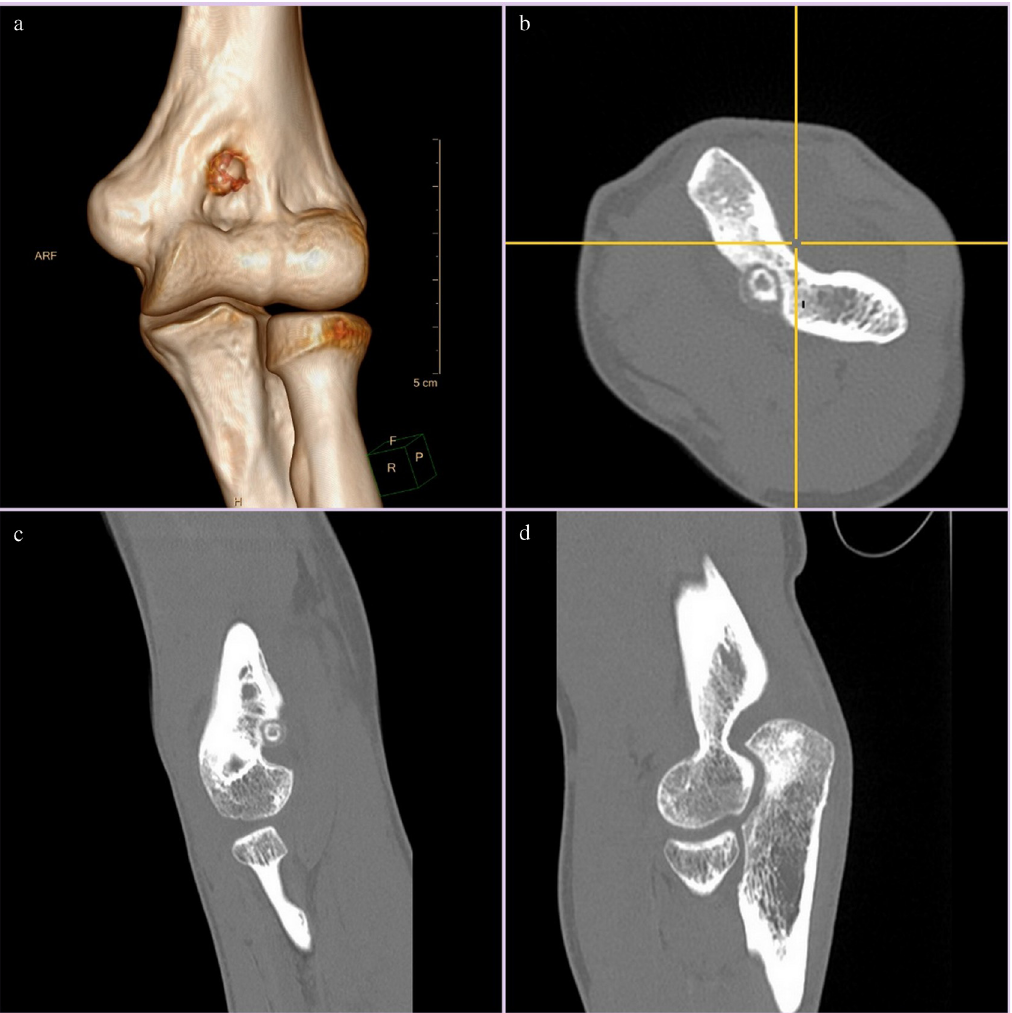
Figure 1. Computed tomography images showing the lesion in coronal 3D reconstruction (a), axial (b), and sagittal (c) views. (d) Shows an otherwise normal elbow